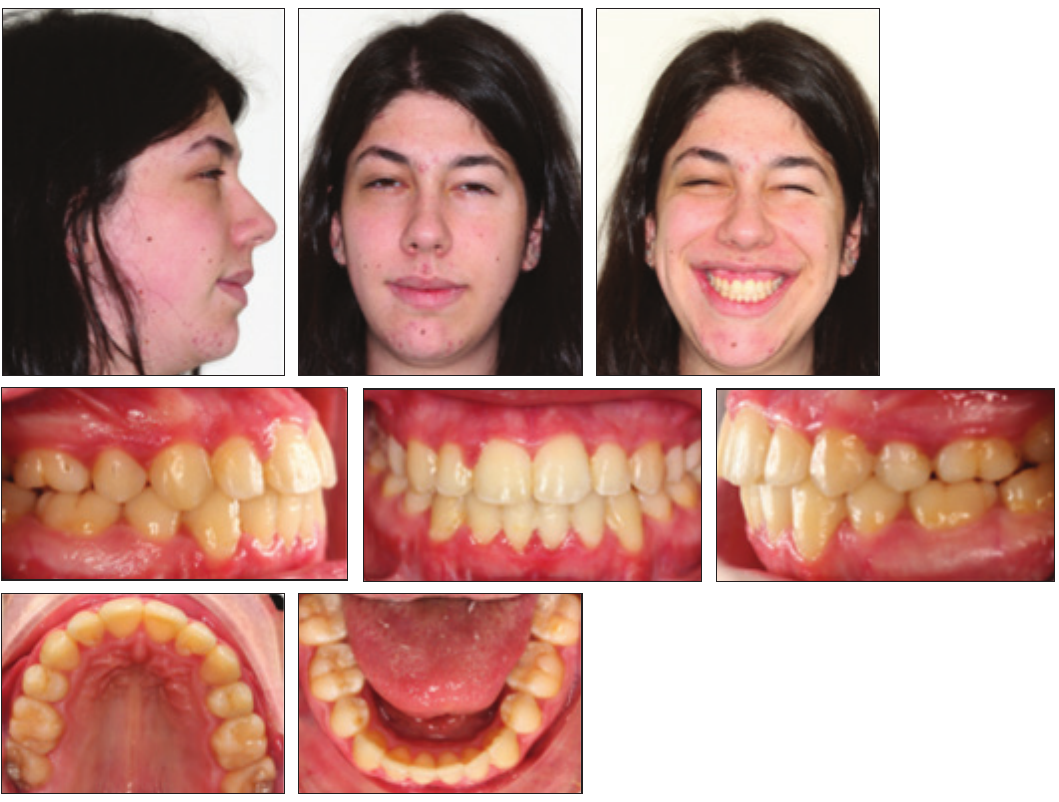
Figure 11. Intra-oral and extra-oral photographs following orthognathic surgery and four months after the removal of appliances; October